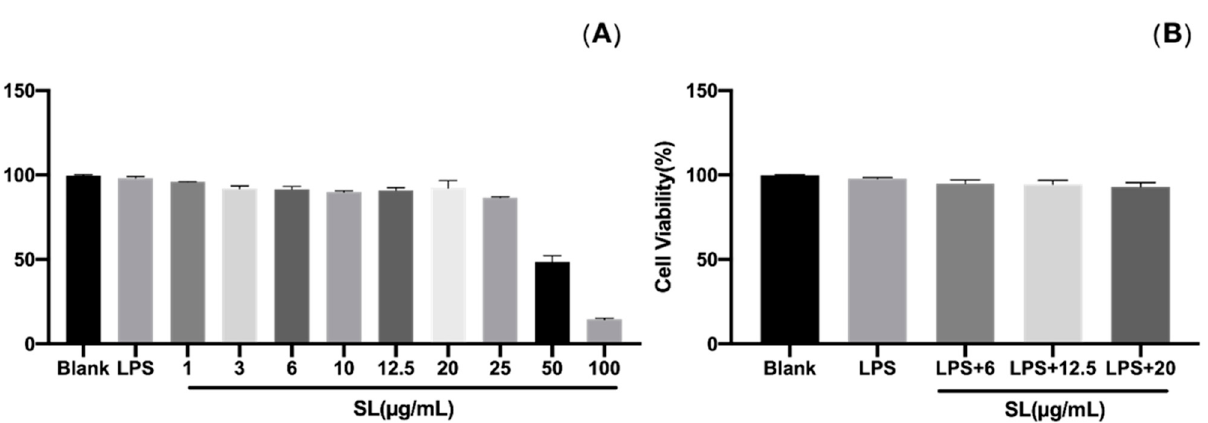
Figure 3. Effect of SLs on the LPS-induced inflammation in RAW264.7 cells. Cells were incubated with LPS (1 μ g/mL) with or without SL for 24 h. ( A ) Secretions of NO were determined using a NO detection kit; ( B ) secretions of TNF- α were measured by a TNF- α ELISA kit; ( C ) secretions of IL-6 were measured by an IL-6 ELISA kit. The results are presented as the mean ± standard error (n = 3), and a p-value less than 0.05 was expressed as statistically significant (###, p < 0.001 vs. blank group; **, ***, p < 0.01, 0.001 vs. LPS treatment group). 3.4. SL Downregulated LPS-Induced Levels of Intracellular ROS and Ca 2+ Generally, the inflammatory response leads to a large increase in reactive oxygen species (ROS) and is closely related to the change in intracellular Ca 2+ concentration. Flow cytometry analysis showed that LPS induction could stimulate the production of ROS and the influx of Ca 2+ . As shown in Figure 4, SL significantly reversed the LPS-induced levels of ROS and intracellular Ca 2+ in RAW264.7 cells, which depended on the concentration.